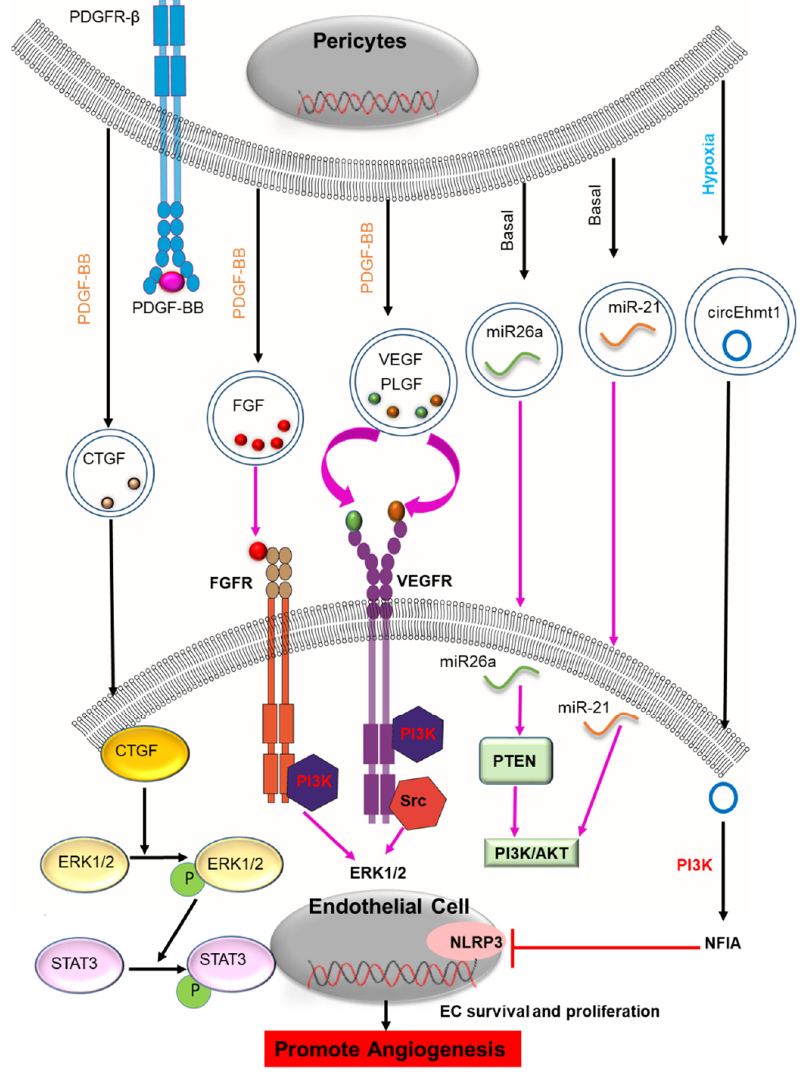
Figure 2. Postulated mechanisms through which PC-EVs are involved in angiogenesis. In response to PDGF-BB, PC-EVs containing several growth factors (CTGF, PLGF, FGF, VEGF) are released. These are transferred to the recipient endothelial cells (ECs) to induce pro-angiogenic signaling in the ECs and promote angiogenesis. CTGF activates the ERK1/2-STAT3 axis in vascular endothelial cells and facilitates the onset of the initial stage of angiogenesis. VEGF and FGF released by platelet-derived EVs act on the VEGF and FGF receptors to exert a pro-angiogenic effect by activating PI3 kinase, src kinase, and ERK1/2. The cargo of EVs also has various miRNAs. Among these, miR26a targets PTEN, activating PI3K/AKT to promote survival and proliferation in the ECs and, thus, angiogenesis. Under hypoxic conditions, PC-released EVs contain circular RNA. Among the circRNAs, circEhmt1 enhances the expression of the transcription factor NFIA while inhibiting the NRLP3 inflammasome, thereby promoting survival and proliferation of the ECs and promoting angiogenesis. The black arrow indicates identified components and mechanism of action of PC-EVs, and the magenta arrow indicates hypothesized Mechanism in PC-EVs based on identified mechanisms from other EVs. (miRNA: an acronym for micro RNA; circRNA: circular RNA; EVs: extracellular vesicles; VEGF: Vascular endothelial growth factor; PLGF: placental growth factor; CTGF: connective tissue growth factor; ERK1/2: extracellular signal-regulated kinase 1 and 2; PI3K: phosphoinositide 3-kinase; PTEN: phosphatase and TENsin homolog deleted on chromosome 10; STAT-3: Signal transducer and activator of transcription).